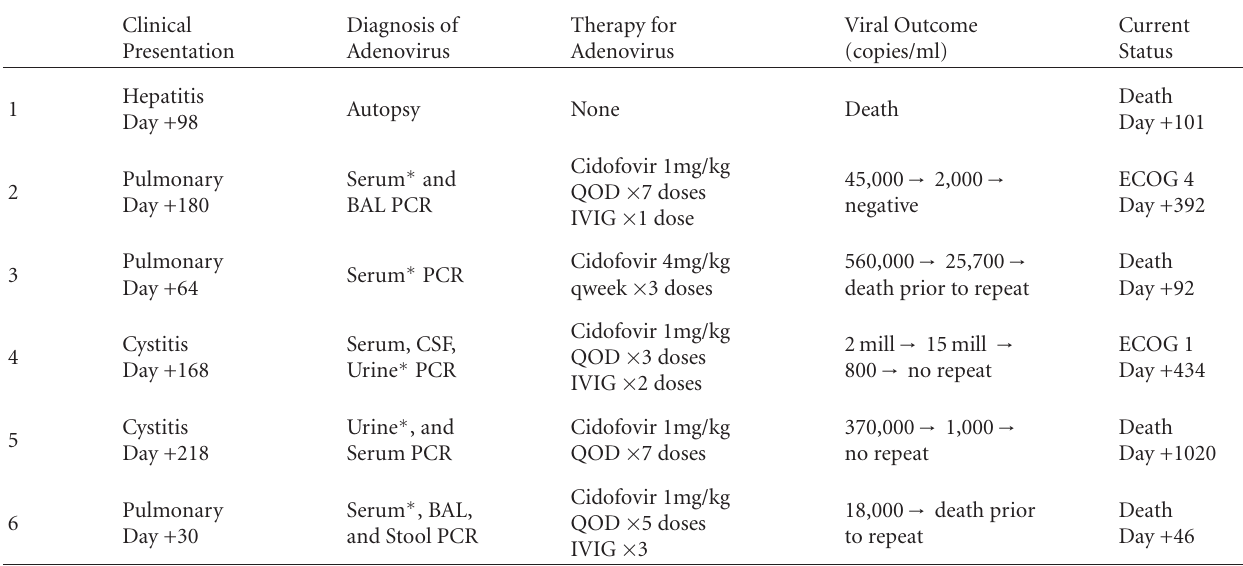
Table 2: Clinical course of Adenovirus